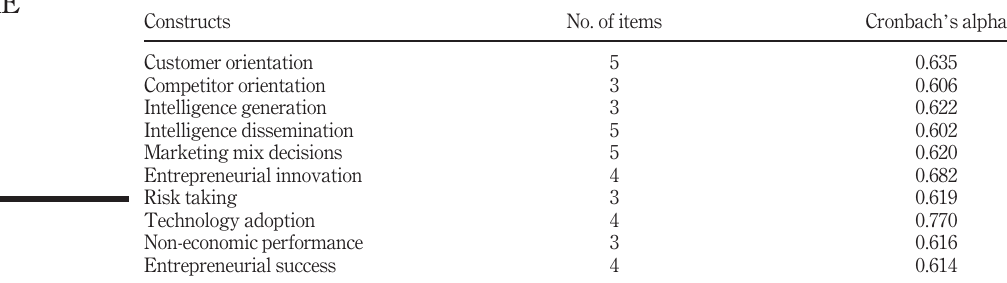
Table I. Coef fi cient alpha and descriptive statistics